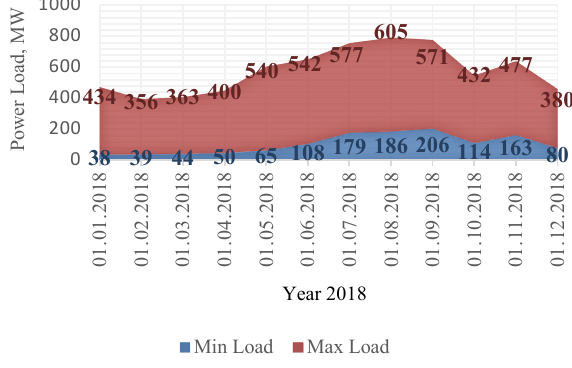
Fig. 1. Load demand trend of